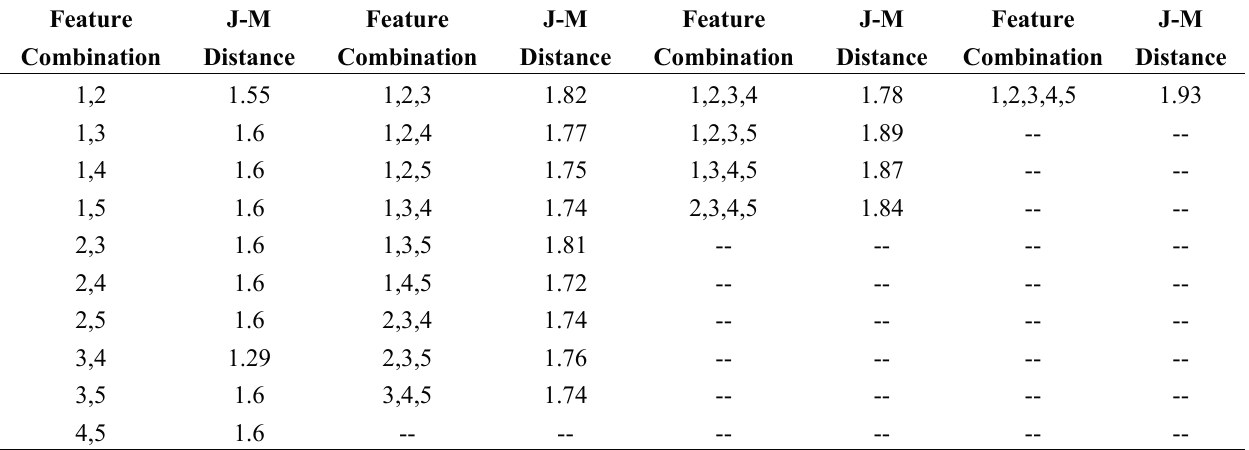
Table 4. The J-M distances between different feature combinations (1: Max NDVI value, 2: Min NDVI value, 3: Integral D35-D45, 4: Integral of NDVI, 5: